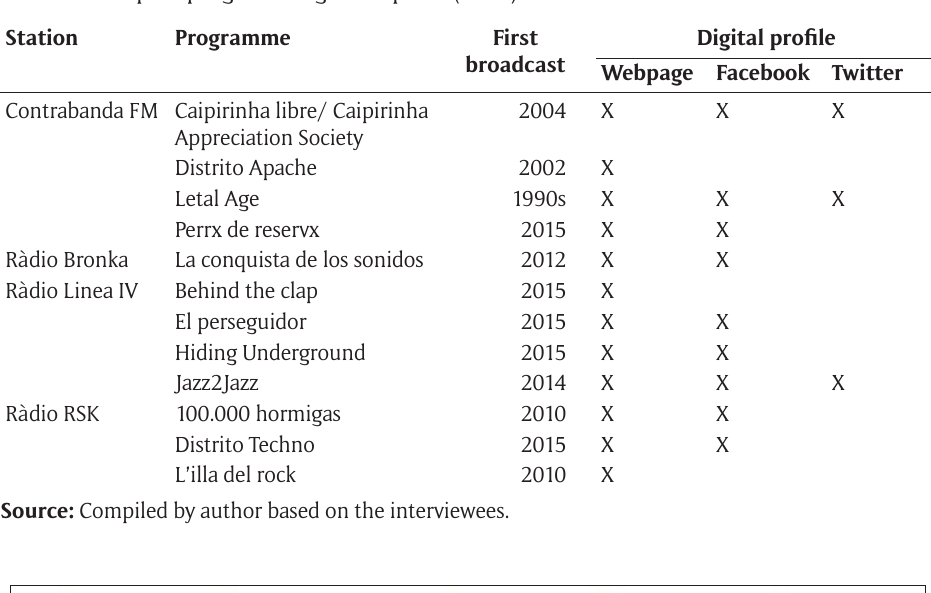
Table 2: Sampled programming description (2016).